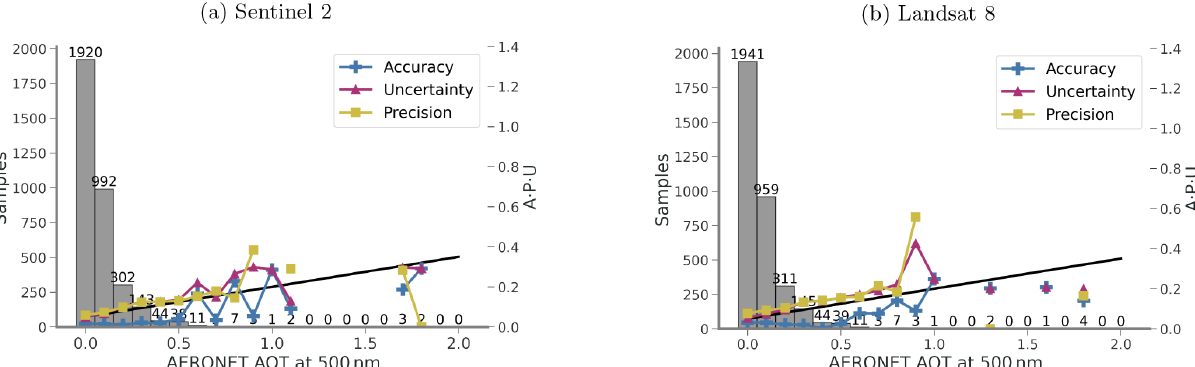
Figure 5. The accuracy ( A ) (plus marker), precision ( P ) (square marker), and uncertainty ( U ) (triangle marker) validation of AOT against AERONET measurements. Threshold uncertainty is shown as black lines in the